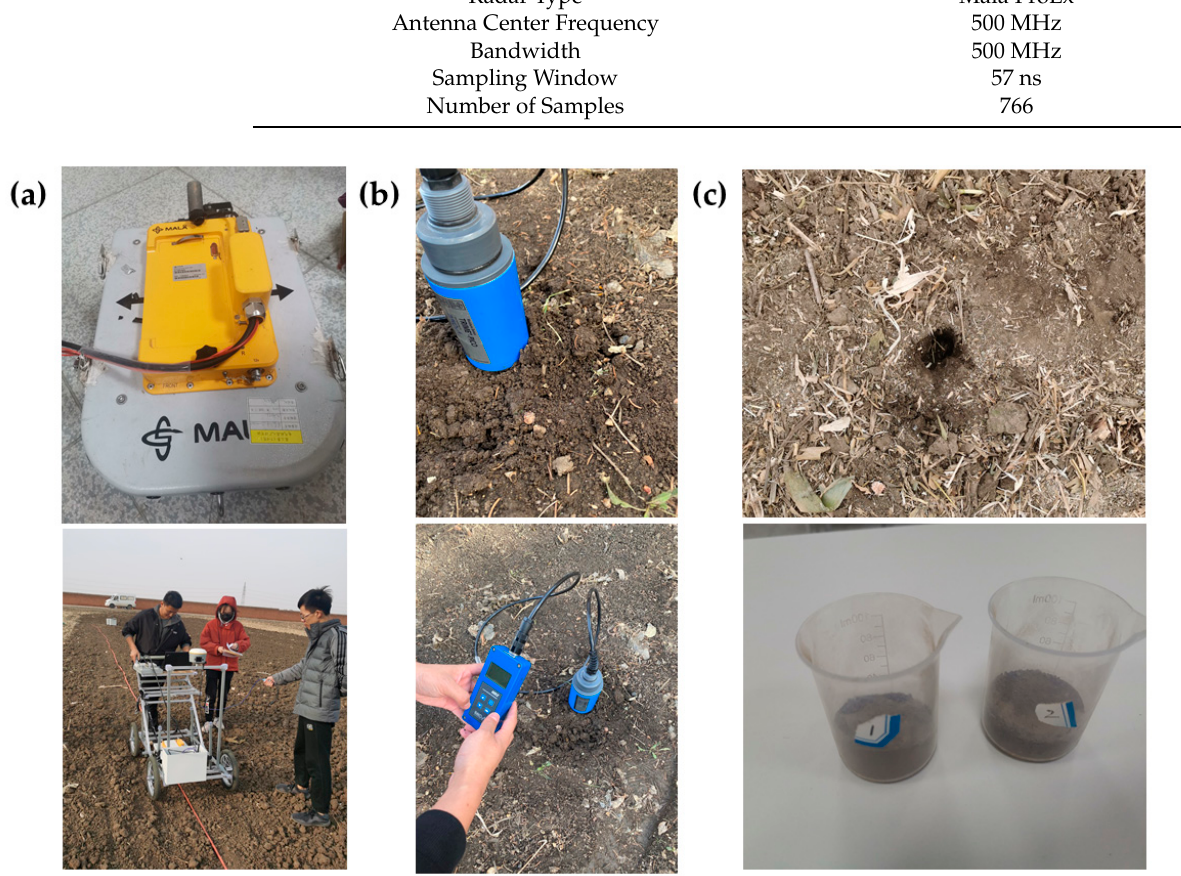
Figure 6. GPR, TDR probe samples, and soil samples in the field. ( a ) Mala ProEx radar acquisition in the field; ( b ) TDR probe spotting in the field; ( c ) field soil sampling and laboratory samples.